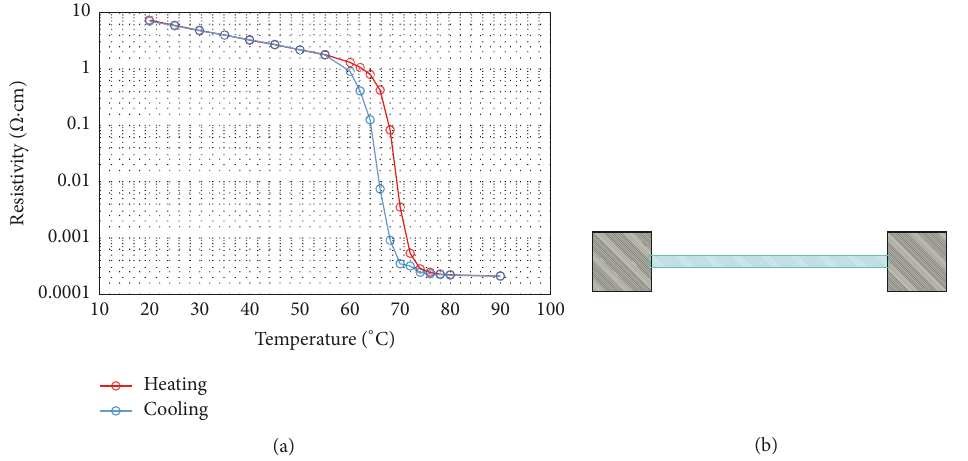
Figure 2: (a) Measurement results of resistivity versus temperature for a VO 2 thin film on sapphire substrate (logarithm scale). (b) Top view of VO 2 test structure. The dimension of VO 2 bar (shown in light blue) is 2 mm × 0.1mm (length × width).